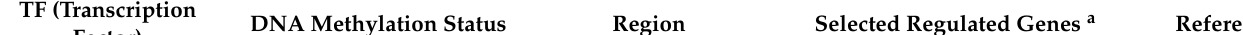
Table 3. Results on identified differentially methylated transcription factors genes known to regulate FGF21 expression. TF (Transcription DNA Methylation Status Region Selected Regulated Genes a Factor)